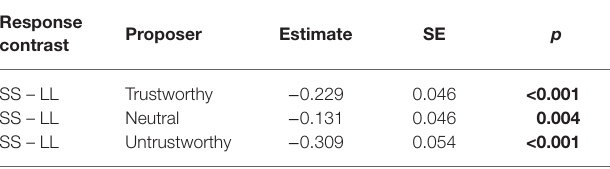
TABLE 5 | Post-hoc comparison of RTs between given response within each level of trustworthiness. Response contrast